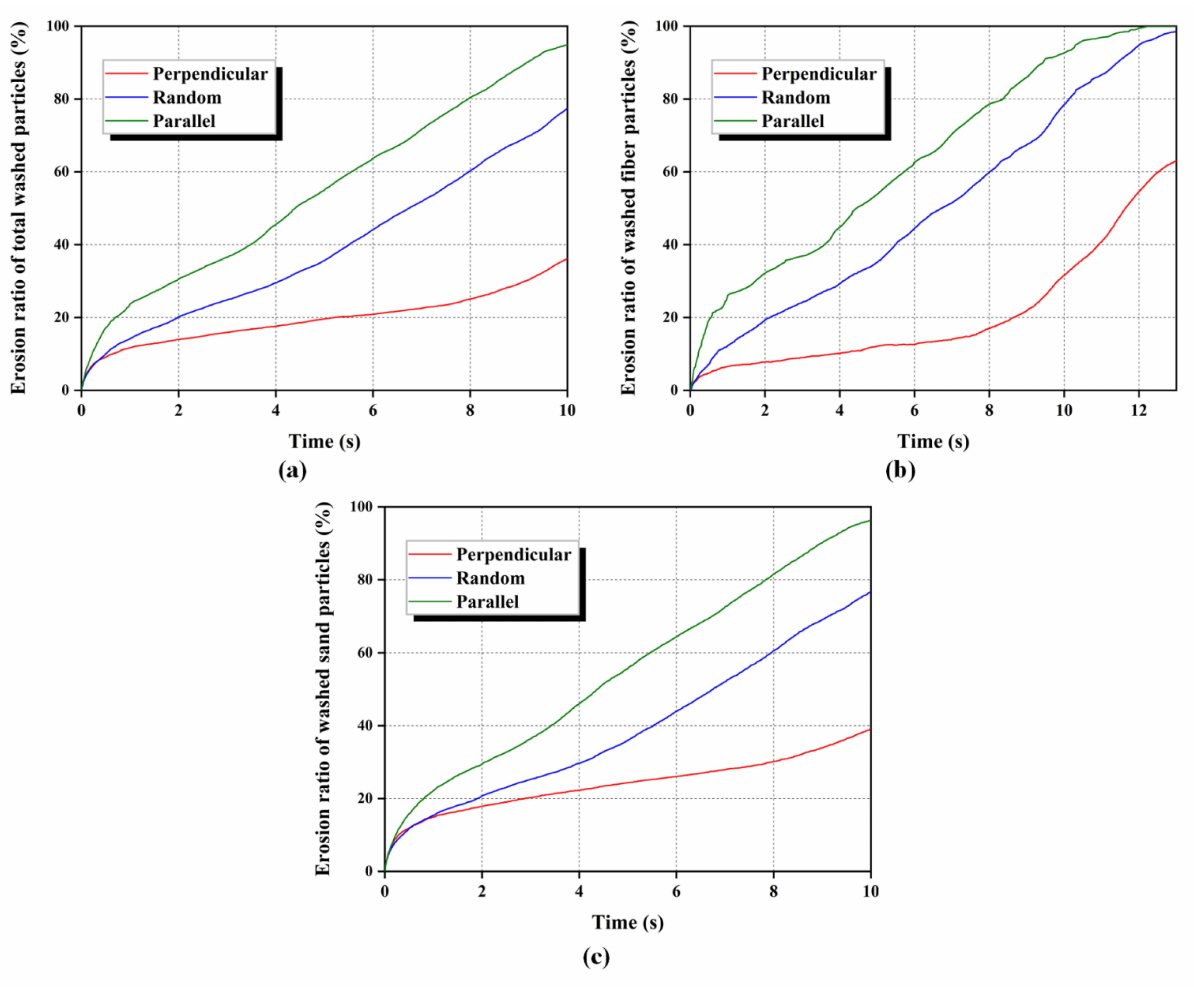
Figure 11. Erosion ratio of different orientated fiber-reinforced sand with time. ( a ) Total washed particles, ( b ) Fiber particles, and ( c ) Sand